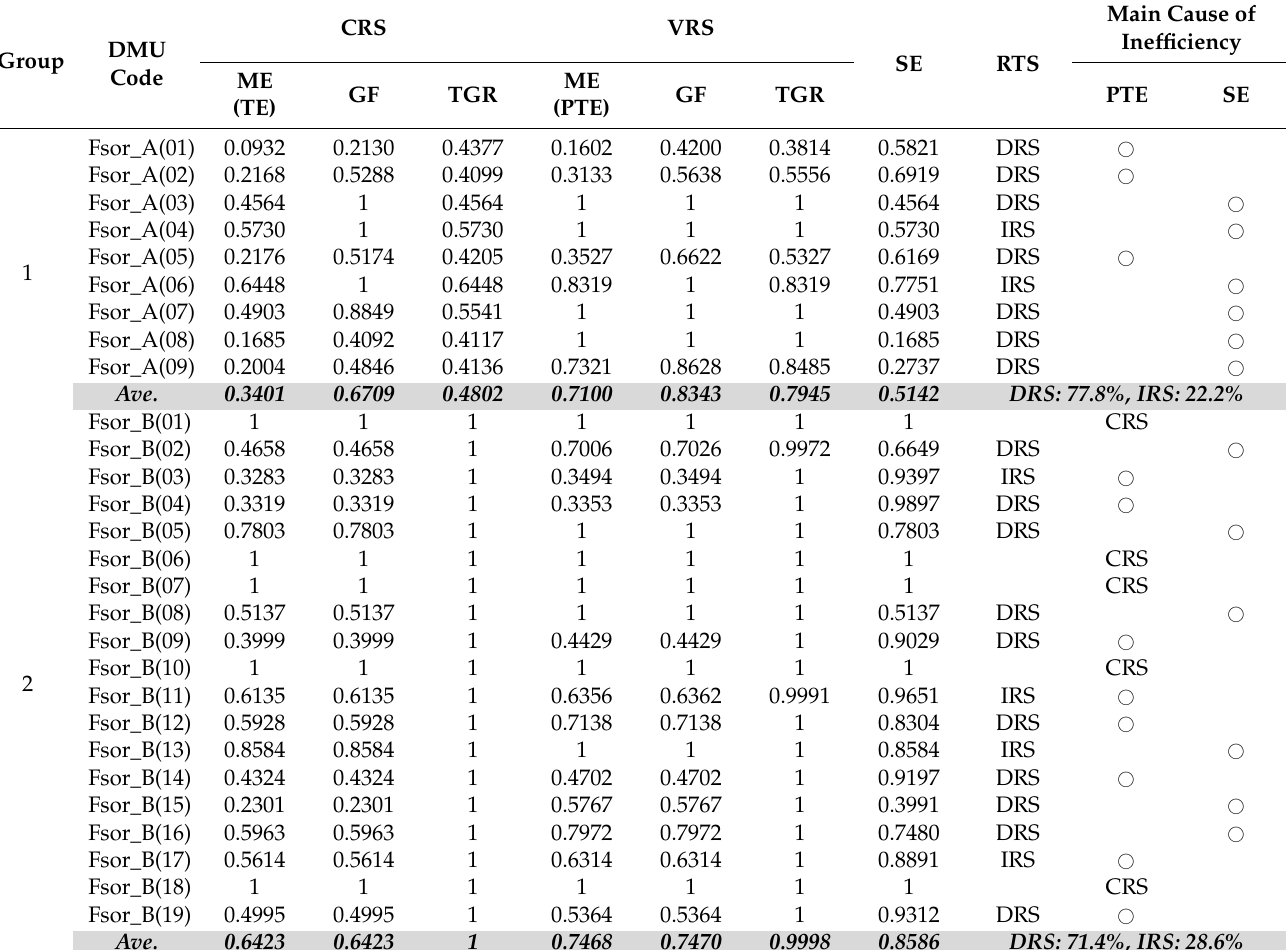
Table 3. Meta-efficiency of